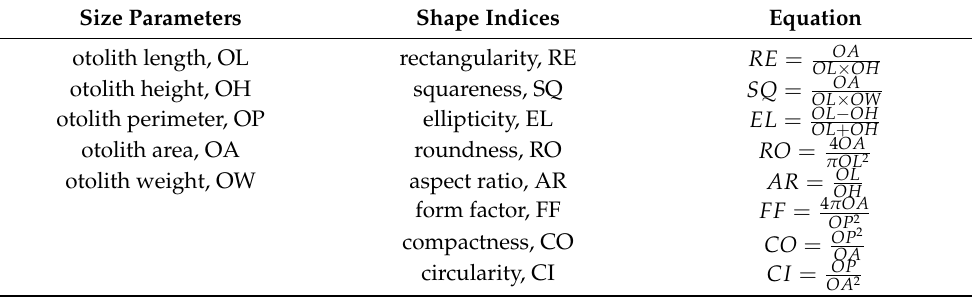
Table 1. Otolith morphometric parameters and shape indices used in this study. Size Parameters Shape Indices Equation otolith length,